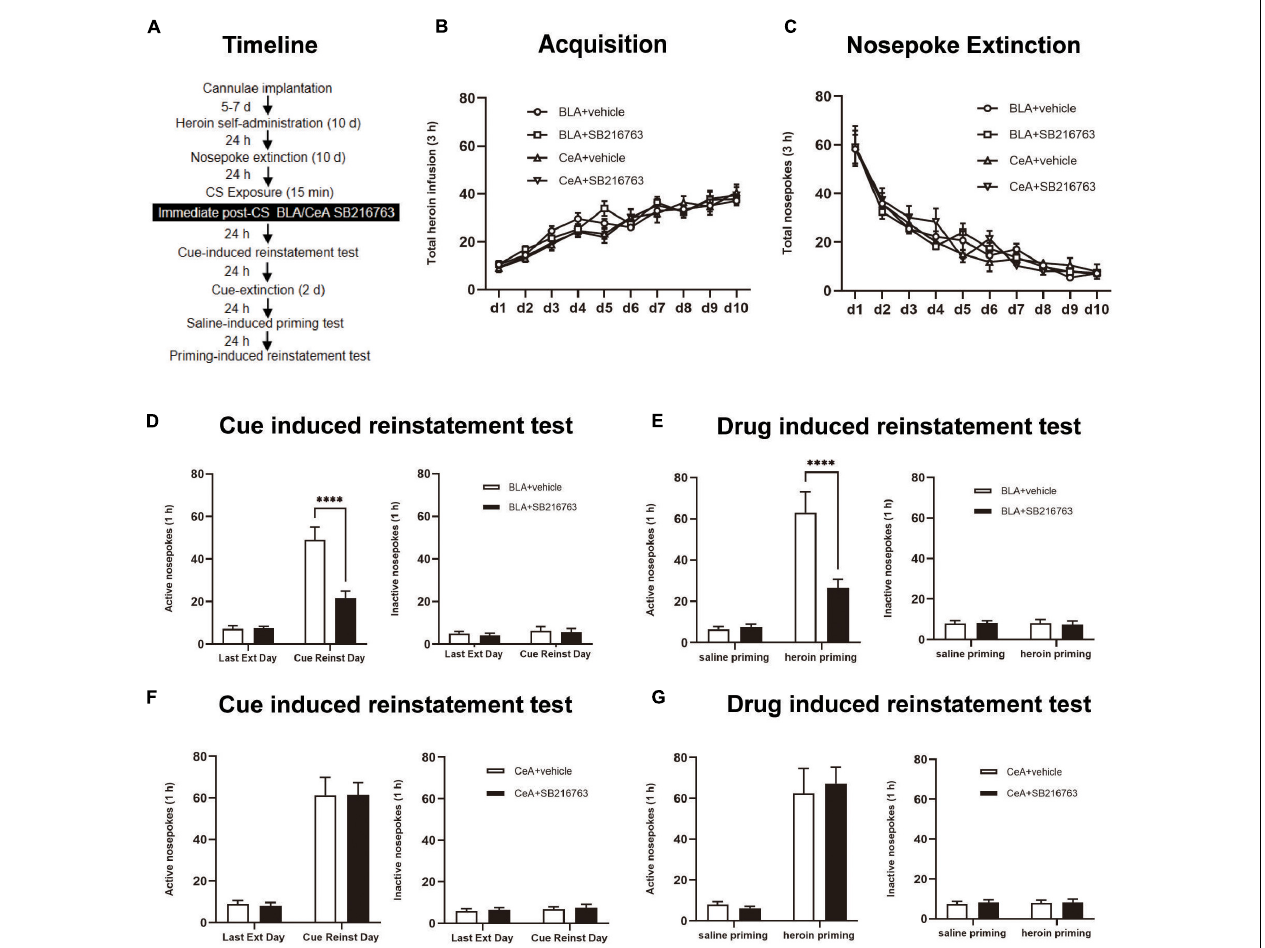
FIGURE 2 | Immediate post-CS SB216763 treatment in BLA rather than CeA can reduce subsequent cue-induced and heroin-primed reinstatement of heroin seeking. (A) Timeline of heroin self-administration, nosepoke extinction, cue-induced reinstatement test and drug-induced reinstatement test. (B) Total number of heroin infusions during acquisition of heroin self-administration. (C) Total number of active nosepoke responses during extinction training sessions. (D,F) Active (left) and inactive (right) nosepoke responses during the last extinction training session and the cue-induced reinstatement test. (D) Nosepoke responses of rats with BLA drug injection. (F) Nosepoke responses of rats with CeA drug injection. (E,G) Active (left) and inactive (right) nosepoke responses across the saline- or heroin- primed reinstatement test. (E) Nosepoke responses of rats with BLA drug injection. (G) Nosepoke responses of rats with CeA drug injection. n = 10–11 mice per group. Data are means ± SEM, ∗∗∗∗ p < 0.0001, compared with the vehicle group. CS, conditioned stimulus; Ext, extinction; Reinst,